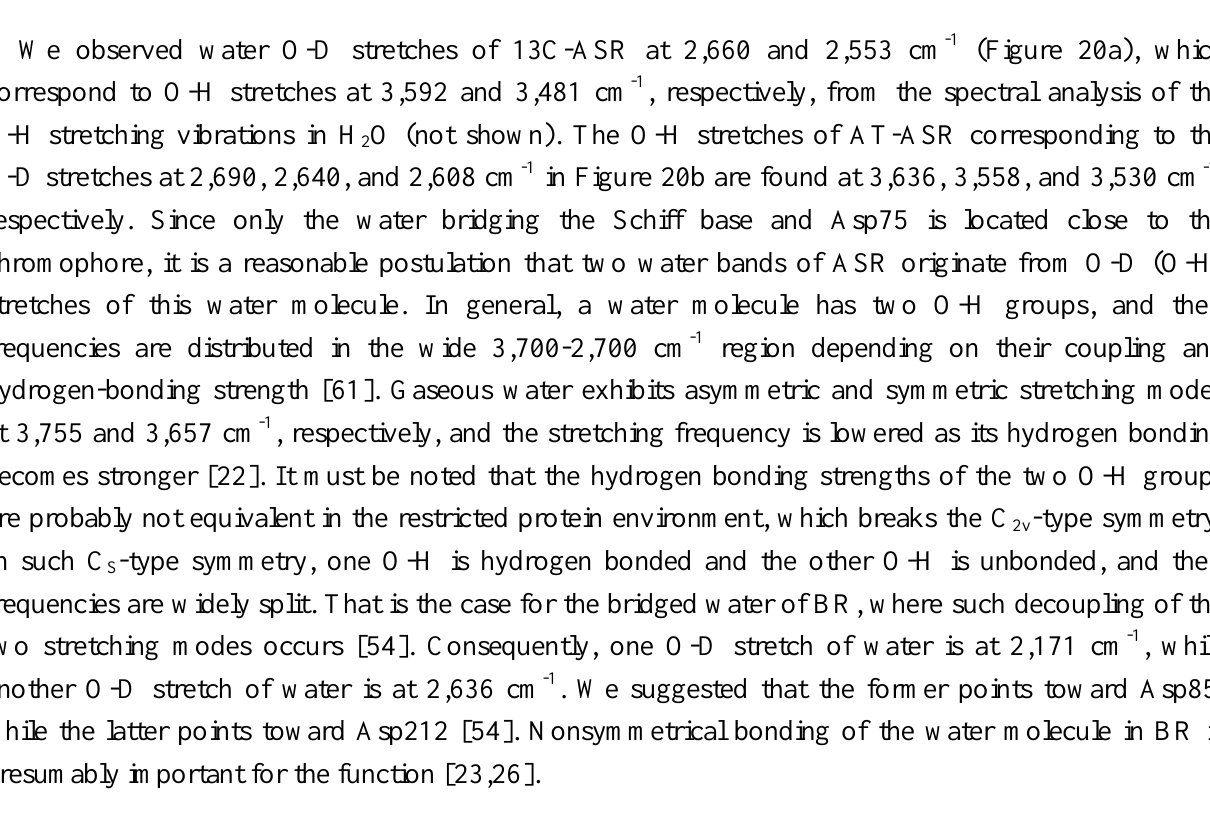
minus ASR infrared K